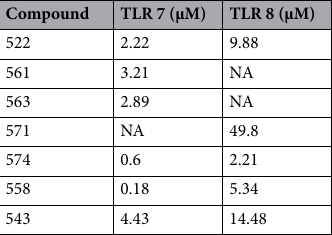
Table 1. List of synthetic TLR7 and/or TLR8 specific agonists with their EC50 values 27